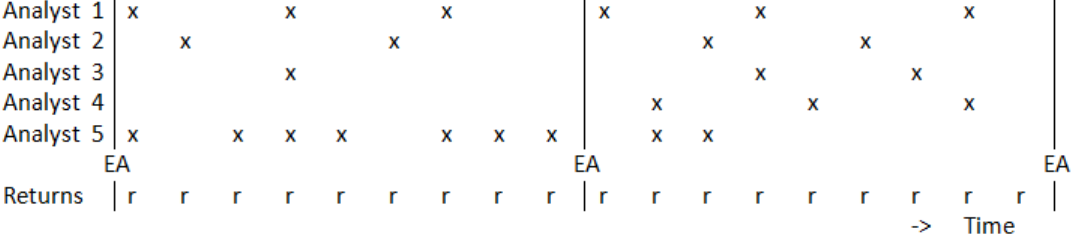
Figure 1. An example of the data format, with x indicating an earnings forecast and EA indicating when a new yearly earnings announcement takes place. This figure shows for five forecasters for two years a variety of hypothetical patterns of forecasts, including analysts that follow a very regular forecasting pattern, or the opposite, and including forecasters that quit producing forecasts or that joined a later year.